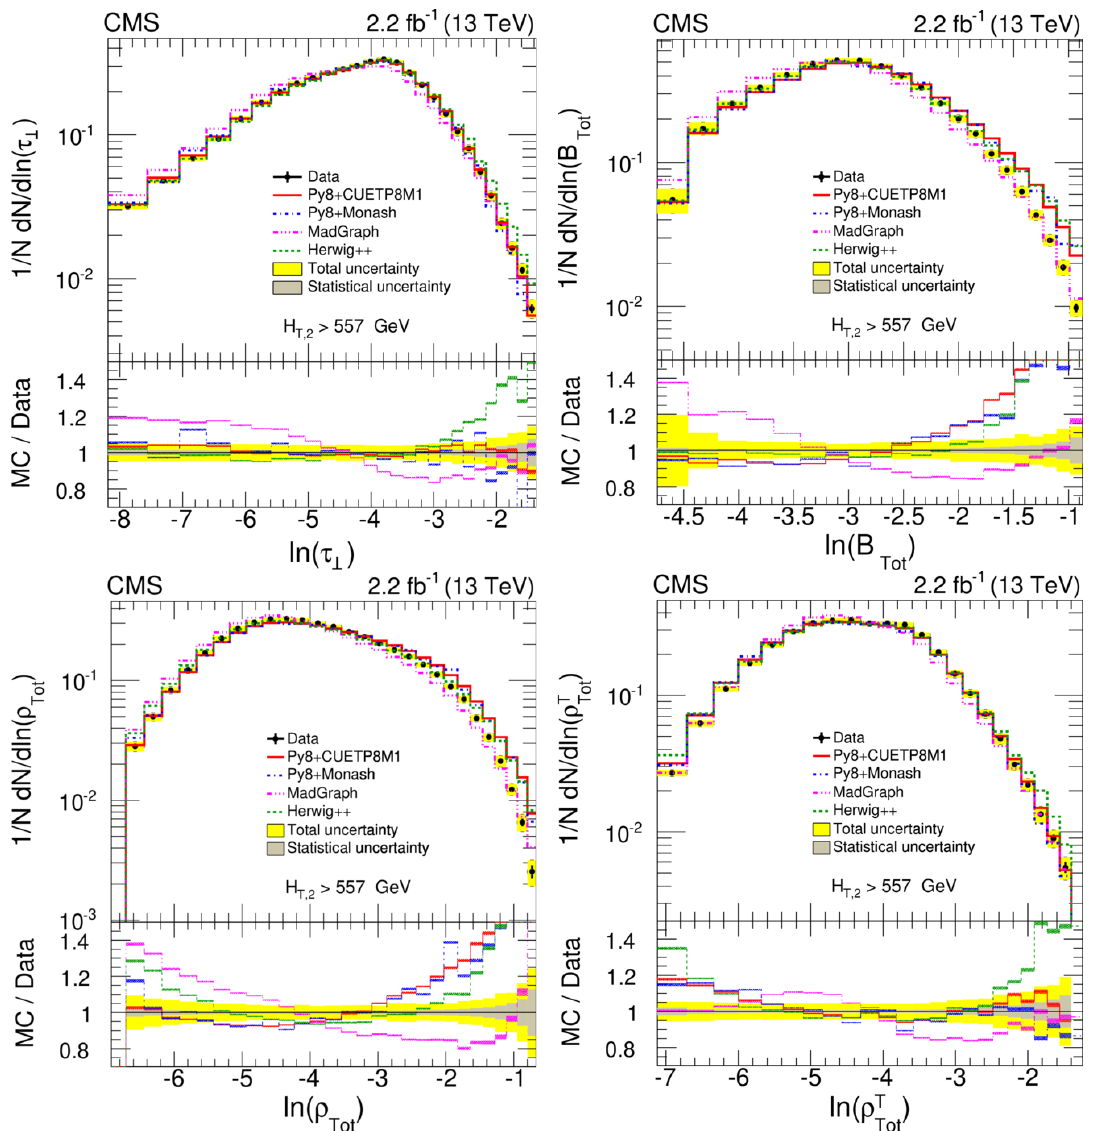
Figure 10 . Normalized di(cid:11)erential distributions of unfolded data compared with theoretical (MC) predictions of pythia 8 CUETP8M1 (red line), pythia 8 Monash (blue dash-dotted line), Mad- Graph 5 a mc@nlo (pink dash-dot-dotted line) and herwig++ (brown dash-dot-dotted line) as a function of ESV: complement of transverse thrust ( (cid:28) ? ) (upper left), total jet broadening ( B Tot ) (up- per right), total jet mass ( (cid:26) Tot ) transverse jet mass ( (cid:26) T ) (lower left) and total transverse jet mass Tot ( (cid:26) T ) (lower right) for H T ; 2 > 557 GeV. In each ratio plot, the inner gray band represents statistical Tot uncertainty and the yellow band represents the total uncertainty (systematic and statistical com- ponents added in quadrature) on data and the MC predictions include only statistical uncertainty.